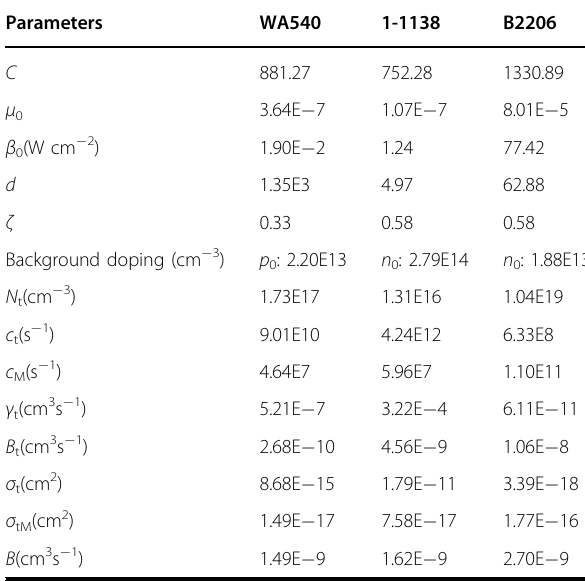
Table 1 Fitting parameters to Eq. 3 and derived radiative and nonradiative